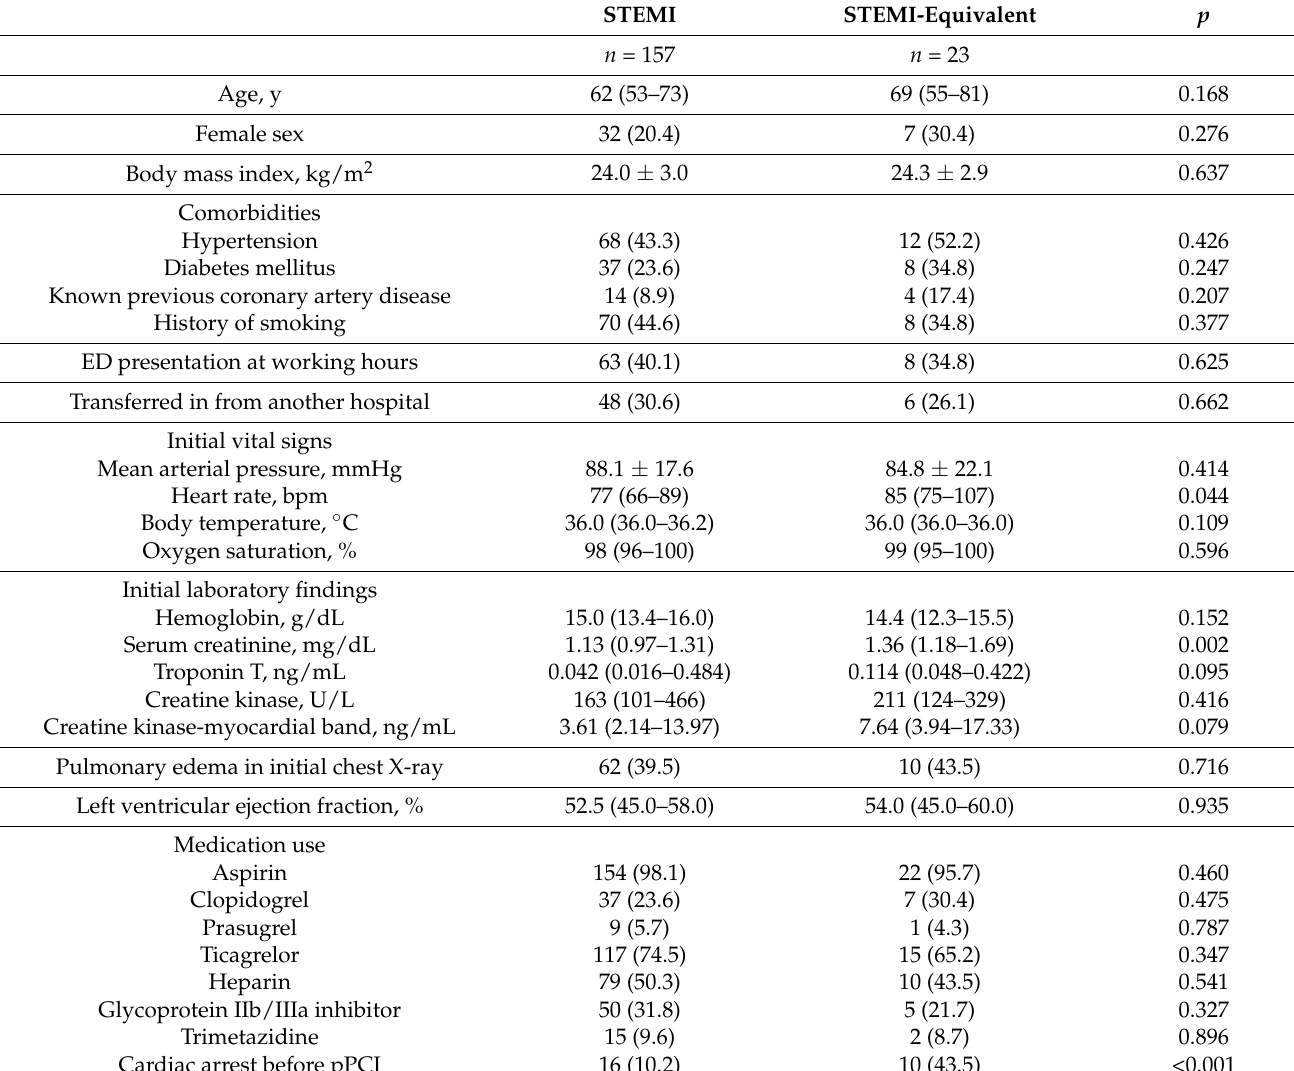
Table 2. Baseline characteristics of patients presenting with STEMI or STEMI-equivalent electrocar- diograms. STEMI STEMI-Equivalent p n = 157 n = 23 62